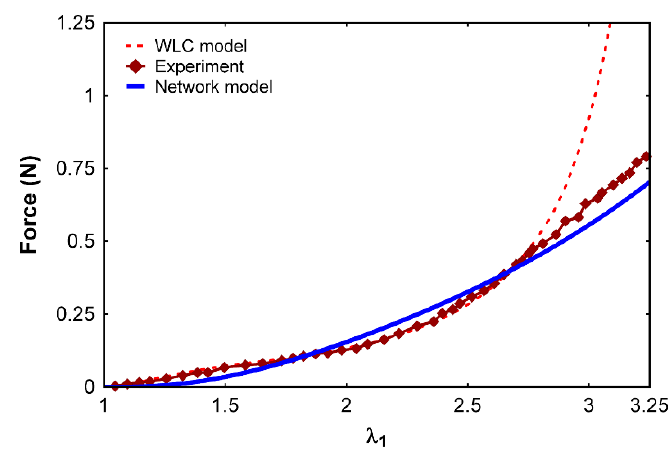
Figure 7. Comparison of the force–stretch relationship for a fibrin clot using our network model with experimental data [2] and with the worm-like chain (WLC) model [2] . experimental data [2] and with the worm-like chain (WLC) model